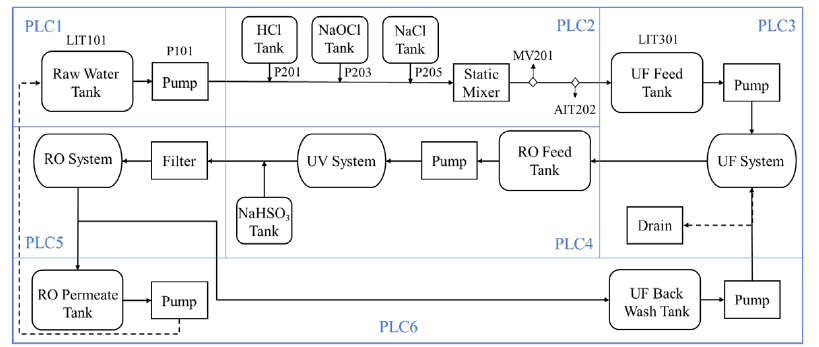
Figure 4. Diagram of SWaT